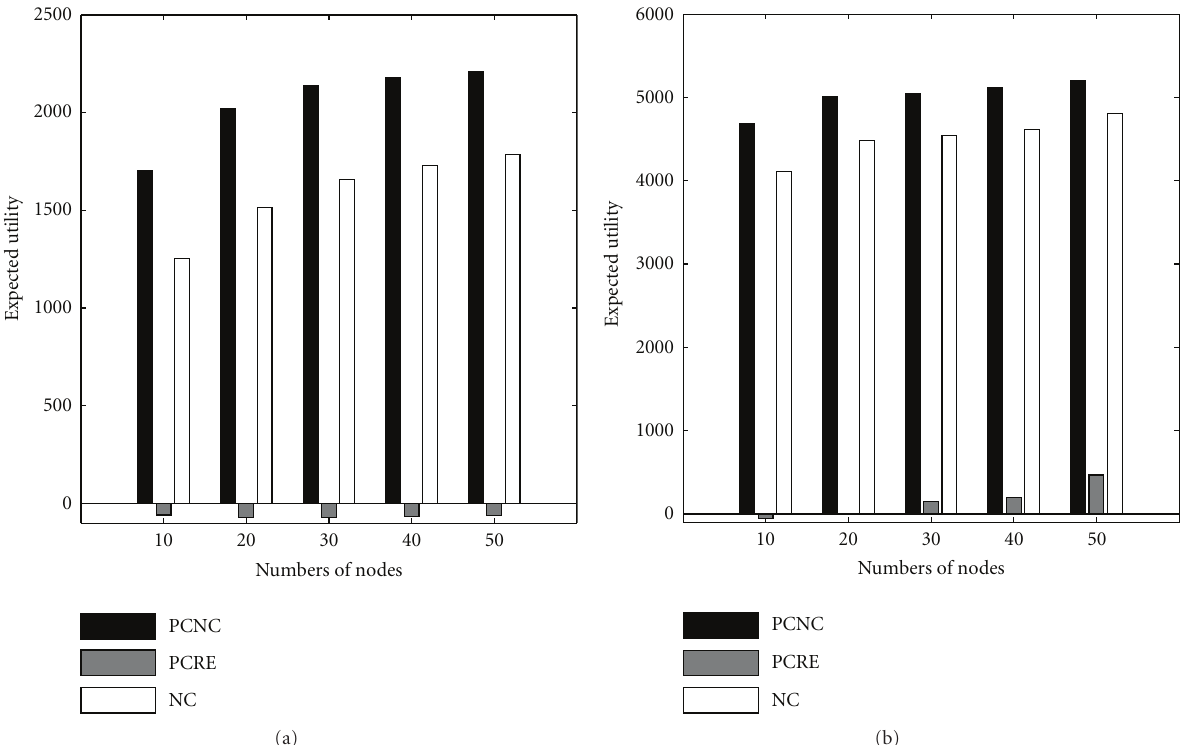
Figure 5: The comparison between three schemes (PCNC, PCRE, and NC) with di ff erent numbers of nodes for unicast routing, when (a) A = 3000 and (b) A = 6000.